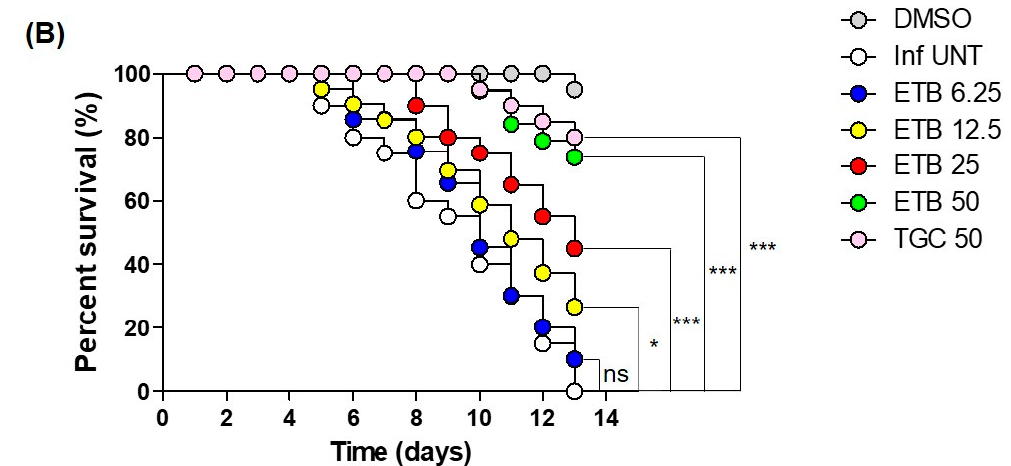
Figure 4. ZF In vivo efficacy of ETB. ( A ) Different concentrations of ETB (6.25, 12.5, 25, and 50 µ M) and TGC (50 µ M) were treated to the ZF infected with Mab R-mWasabi and proliferation or reduction of mWasabi signal in ZF was monitored under the fluorescent microscope. After antibiotics treatment, the bacterial burden of infected ZF was quantified through traditional agar plate quantification method. Data was expressed as the mean log10 CFU per embryo ( n = 10 of each condition) from three independent experiments. ( B ) All infected fishes treated at 6.25, 12.5, 25, and 50 µ M of ETB and TGC (50 µ M). Survival curve was plotted from Mab R-mWasabi infected ZF for 13 days. ( n = 20, representative of three independent experiments). Survival curves were compared with the log-rank (Mantel-Cox) test (* p < 0.05, ** p < 0.01; *** p < 0.001; ns: Not significant). Inf UNT: Infected but not treated control.